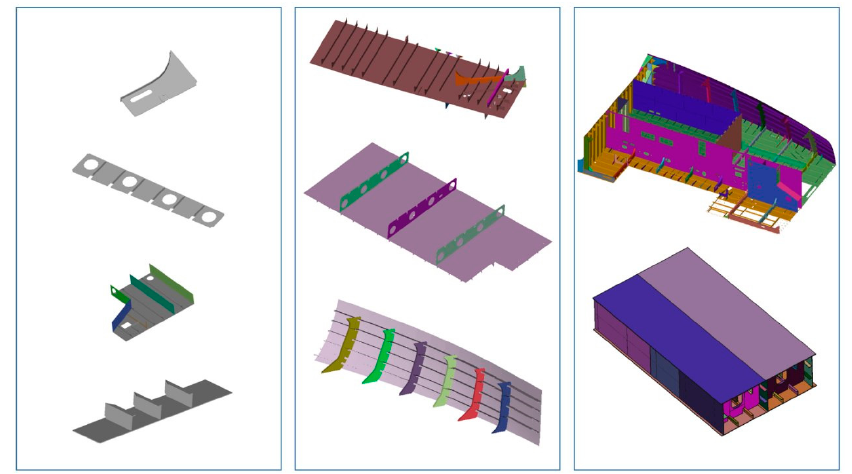
Figure 3. Three types of assembly blocks: L1 (left), L2 (middle), and L3 (right).